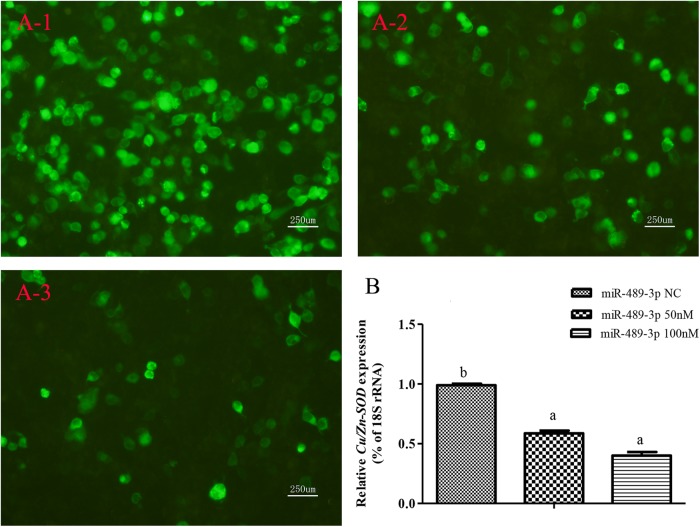
Analysis of regulatory relationships between miR-489-3p and Cu/Zn-SOD
in vitro. (A) Luciferase activities were analyzed by co-transfecting Cu/Zn-SOD-3′UTR and 50 nM or 100 nM miR-489-3p mimic or same dose of miR-489-3p NC into hepatocytes. (A-1) pEGFP-C1-3Flag-Cu/Zn-SOD-3′UTR and 100 nM miR-489-3p NC were constructed and co-transfected into hepatocytes. Fluorescence was analyzed at 48 h after transfection; (A-2) pEGFP-C1-3Flag-Cu/Zn-SOD-3′UTR and 50 nM miR-489-3p mimic were constructed and co-transfected into hepatocytes. Fluorescence was analyzed at 48 h after transfection; (A-3) pEGFP-C1-3Flag-Cu/Zn-SOD-3′UTR and 100 nM miR-489-3p mimic were constructed and co-transfected into hepato cytes. Fluorescence was analyzed at 48 h after transfection; (B) Transcript levels of Cu/Zn-SOD in hepatocyte level at 48 h as determined by qRT-PCR. Different lowercase letters indicate significant differences among experimental groups (P < 0.05, Duncan’s multiple comparison).